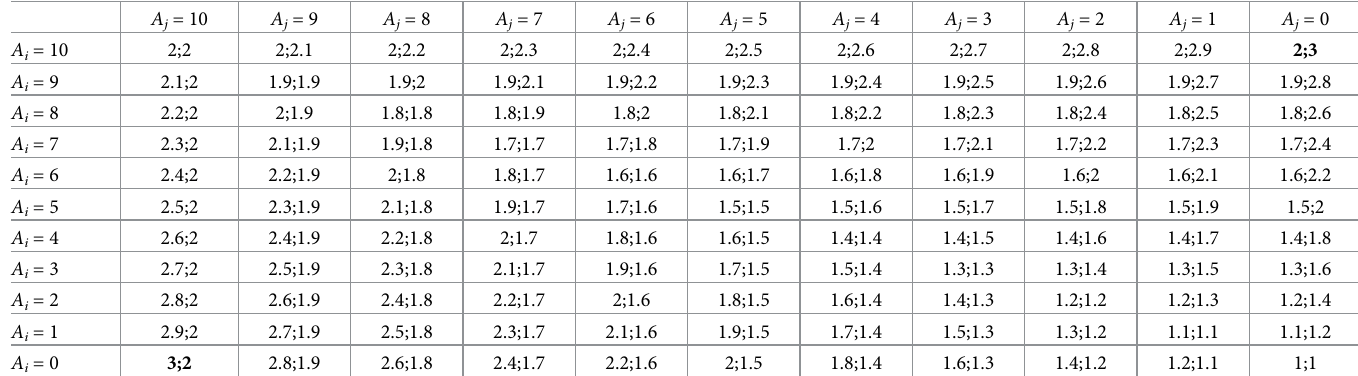
Table 2. Payoff matrix for best-shot production, with ω i = ω j =